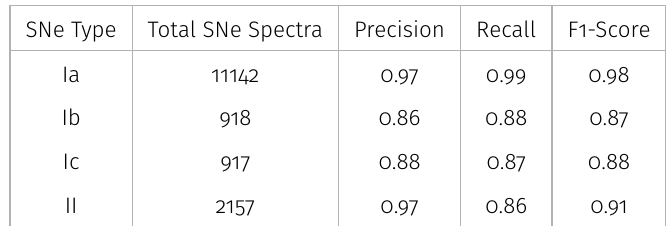
Table III. Full Data Results for SNe classified by